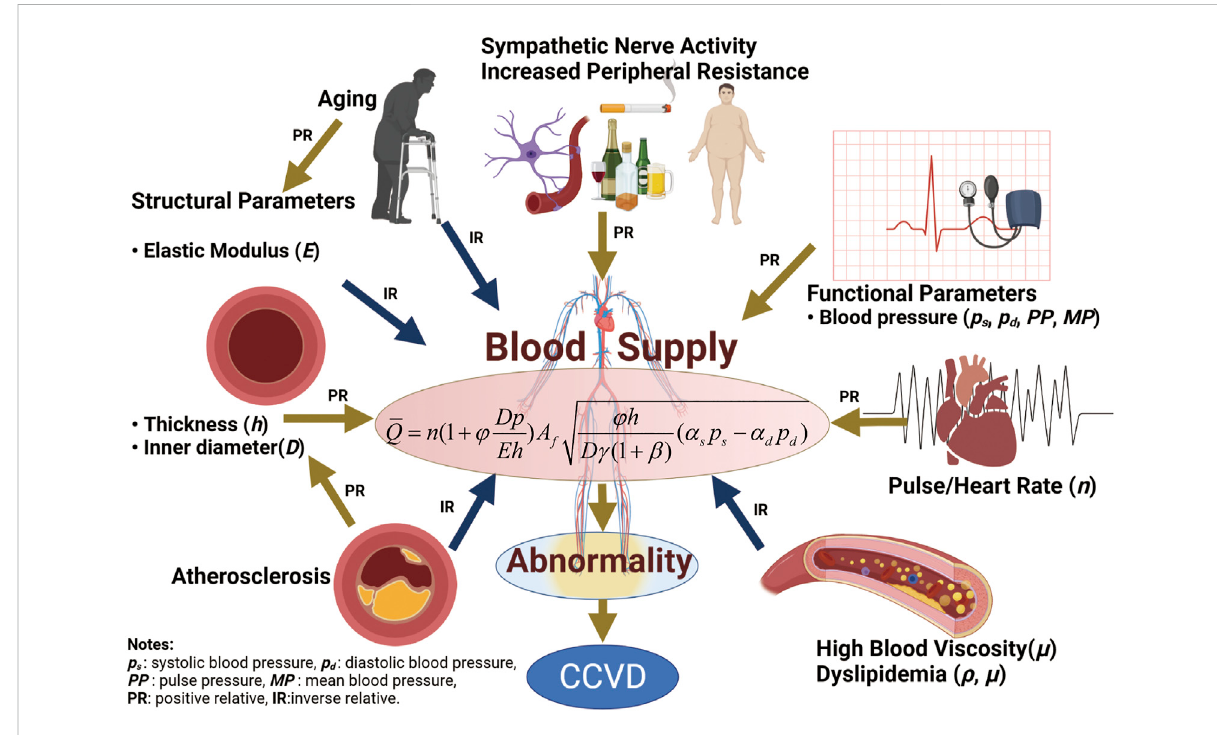
FIGURE 8 Relationship between blood fl ow and physiological